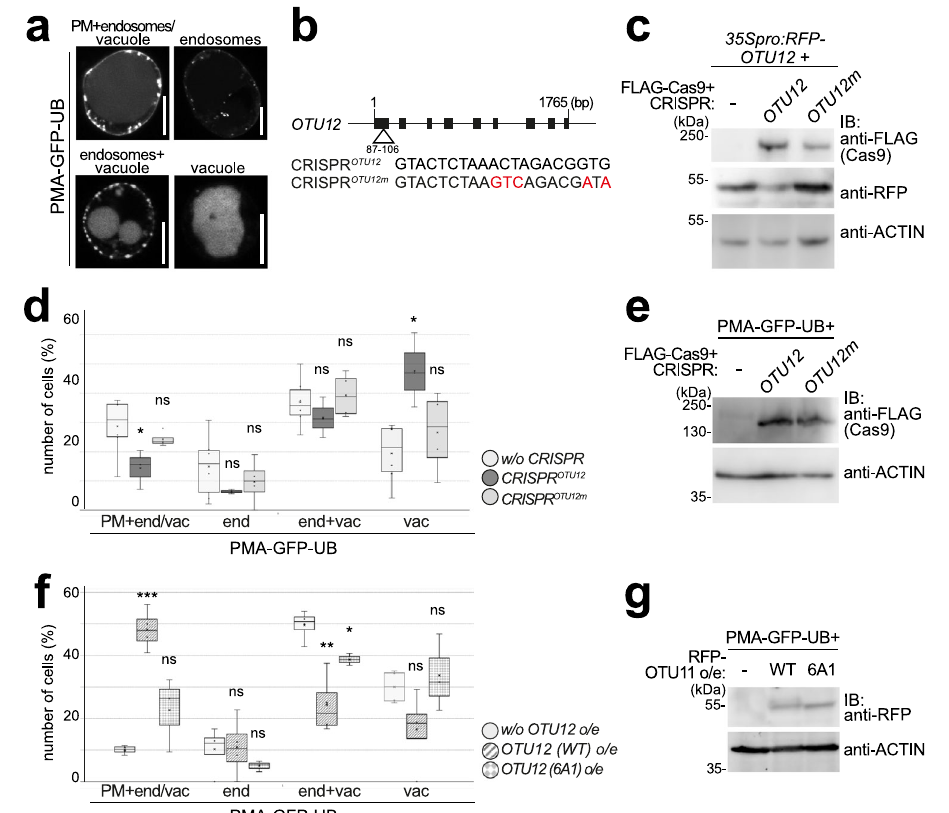
Fig. 4 | OTU11 and OTU12 modulate the endosomal transport of PMA-GFP-UB. a Representative confocal images of protoplasts transformed with PMA-GFP-UB. The experiment was repeated at least three times. Scale bars: 10 µ m. b Schematic representation of the CRISPR target- ( CRISPR OTU12 ) and mutated target- ( CRISPR O- TU12m ) sequences. c Protein extracts of protoplasts transformed with 35Spro:RFP- OTU12 alone, and with 35Spro:RFP-OTU12 and CRISPR OTU12 /3xFLAG-Cas9 or CRIS- PR OTU12m /3xFLAG-Cas9 were subjected to anti-FLAG and anti-RFP immunoblots. An anti-ACTIN antibody was used as loading control on the anti-FLAG-treated mem- brane. d Protoplasts expressing PMA-GFP-UB alone ( n =225 cells), PMA-GFP-UB with CRISPR OTU12 − 3xFLAG-Cas9 ( n =148 cells), and PMA-GFP-UB with CRISPR OTU12m − 3xFLAG-Cas9 ( n =125cells)wereanalyzedandcellswerecategorizedaccordingto thelocalizationofPMA-GFP-UBasin( a ).Threeindependenttransformationswere performed and the results of all experiments are shown as a box plot. Center line, median; box limits, fi rst and third quartiles; whiskers, 1.5x interquartile range; points, outliers. P values for the PM+endosome/vacuole (PM+end/vac) localiza- tion, without CRISPR/ CRISPR OTU12 P =0.0453 (*0.01< P <0.05), without CRISPR/ CRISPR OTU12m P =0.350 (ns: not signi fi cant); endosome (end), without CRISPR/ CRISPR OTU12 P =0.112 (ns), without CRISPR/ CRISPR OTU12m P =0.410 (ns);